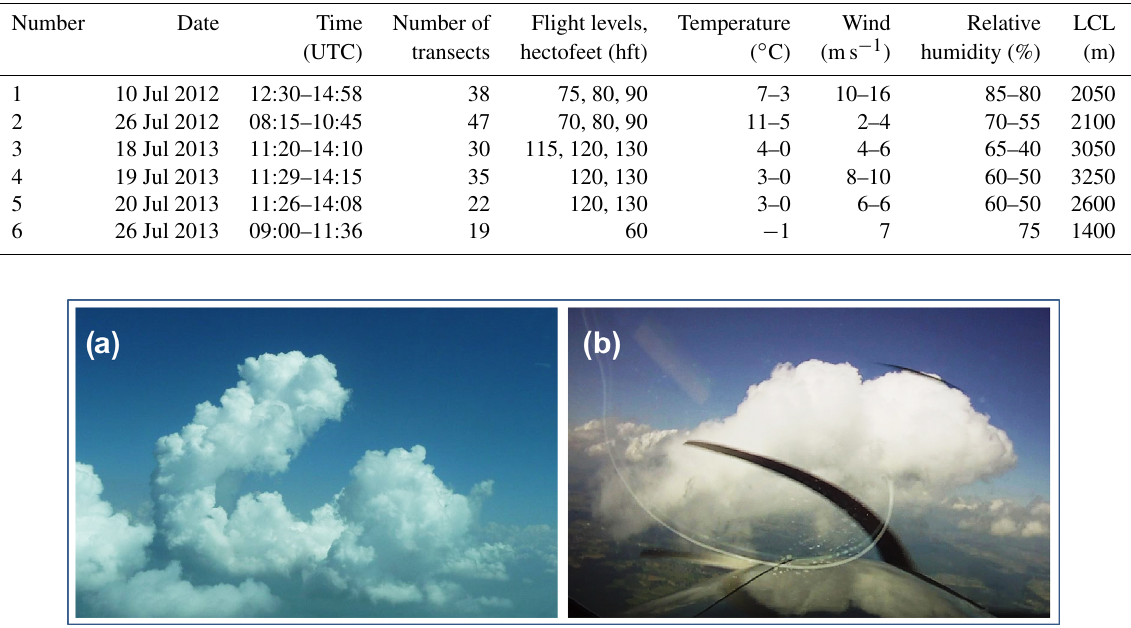
Table 2. Summary of flights conducted during the measurement campaigns in June 2012 and July 2013 with the number of cloud transects used in this study (191 total) and their pressure height measured in hectofeet (i.e. flight levels). The given values for environmental air cor- respond to the lowest and highest flight level. The lifted condensation level (LCL) is estimated with the Henning equation (e.g. Schmeissner et al., 2015) from the profile data measured during takeoff and landing at the airport about 80km north of the target area.